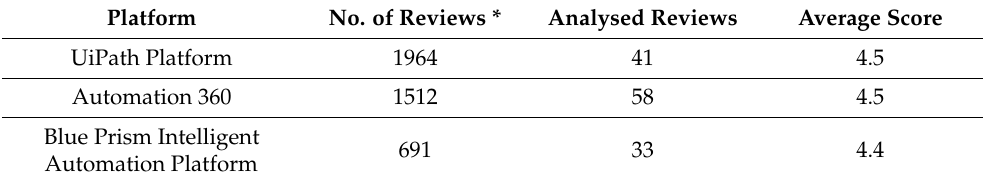
Table 1. Details of the analysed platforms.